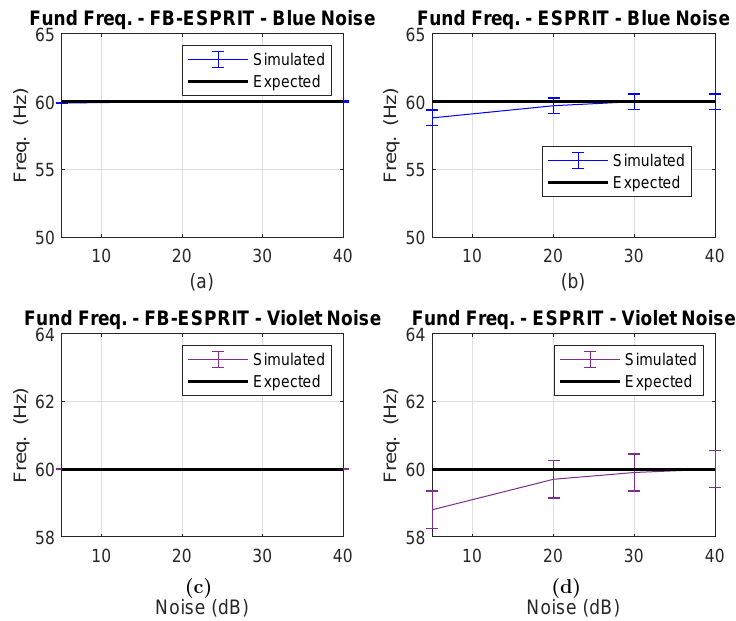
Figure 8. Estimation of fundamental frequency (Fund Freq.) when s 1 ( t ) is contaminated with blue and violet noises; ( a ) by FB-ESPRIT under blue noise, ( b ) by ESPRIT under blue noise, ( c ) by FB-ESPRIT under violet noise, and ( d ) by ESPRIT under violet